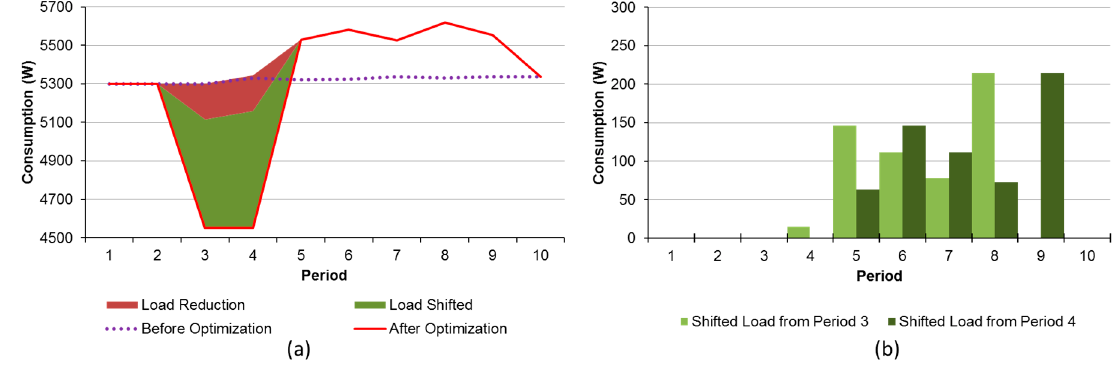
Figure 6. The optimization results for the consumption resources.